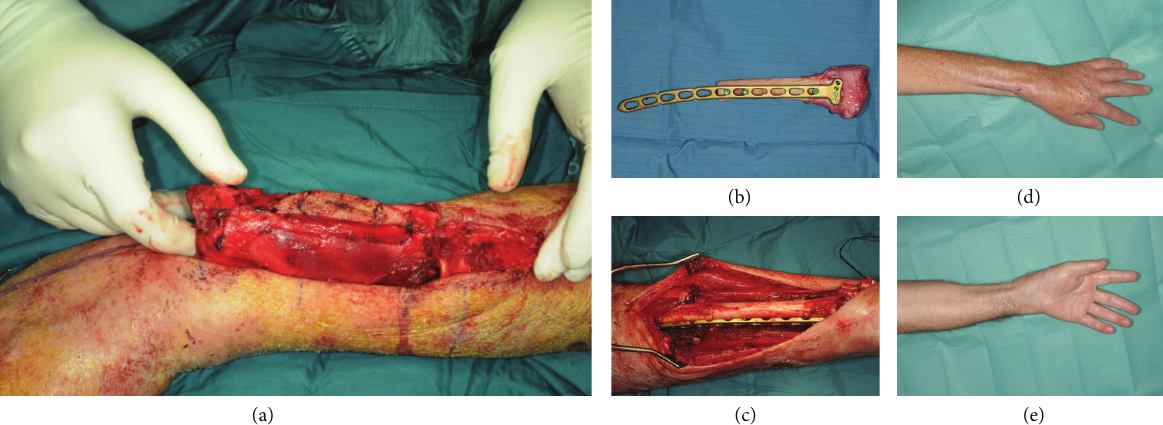
Figure 2: Allograft implantation in the left distal radius after resection of an osteosarcoma in a 64-year-old patient (a–c) and postoperative functional result 7months after operation (d-e).